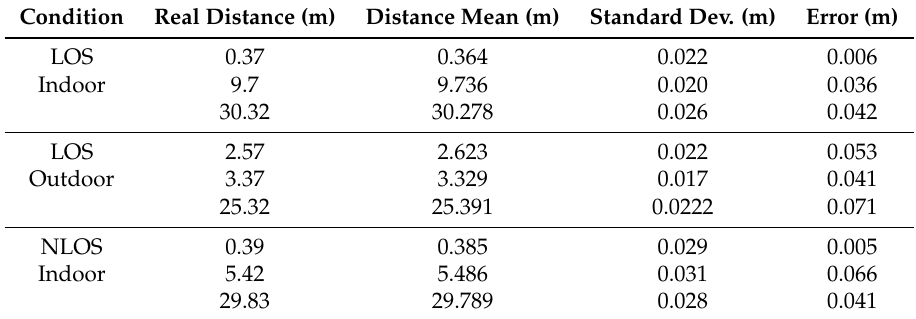
Table 4. UWB Ranging Accuracy in LOS/NLOS condition and Indoor/Outdoor operational